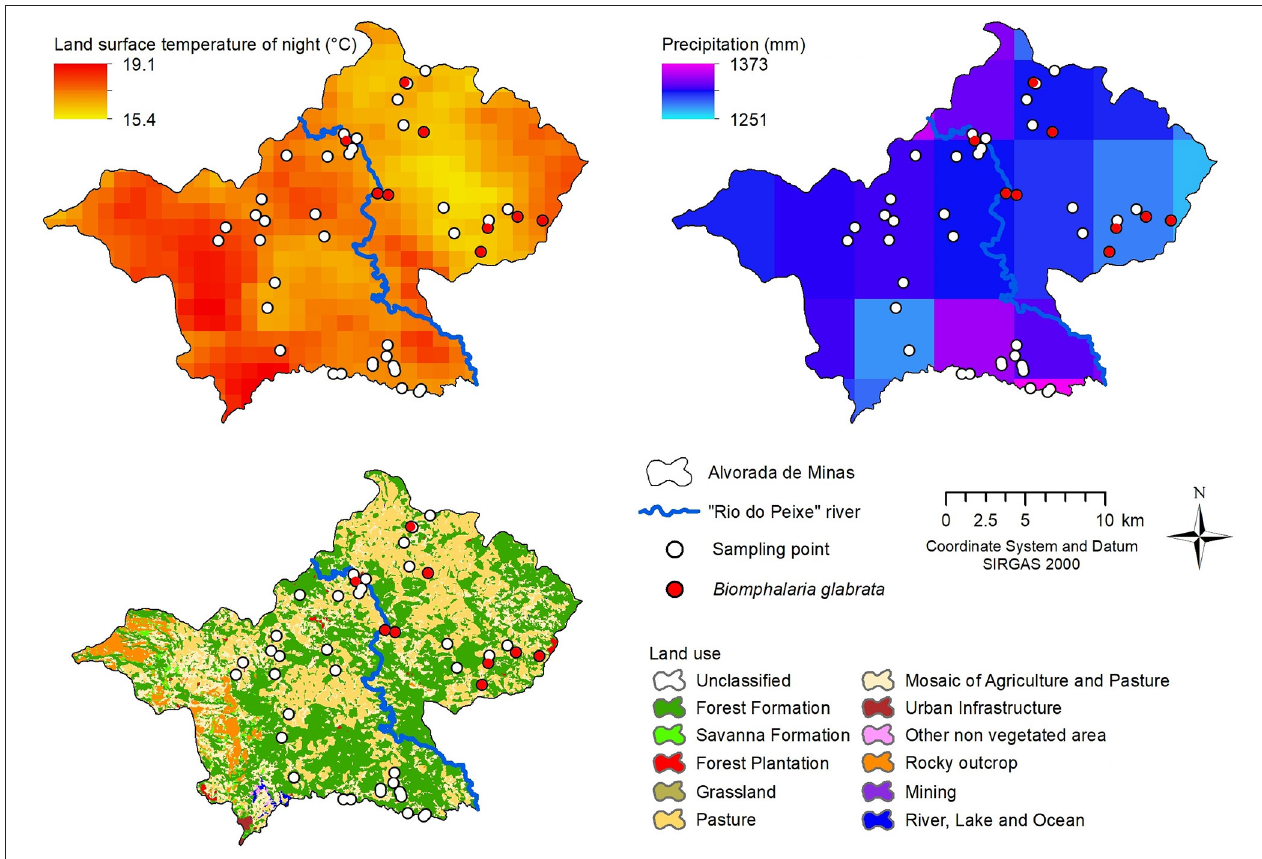
FIGURE 3 | Correlation map of Biomphalaria glabrata with precipitation and land surface temperature at night, using 2018–2019 GEE data and land use map, municipality of Alvorada de Minas, Minas Gerais,